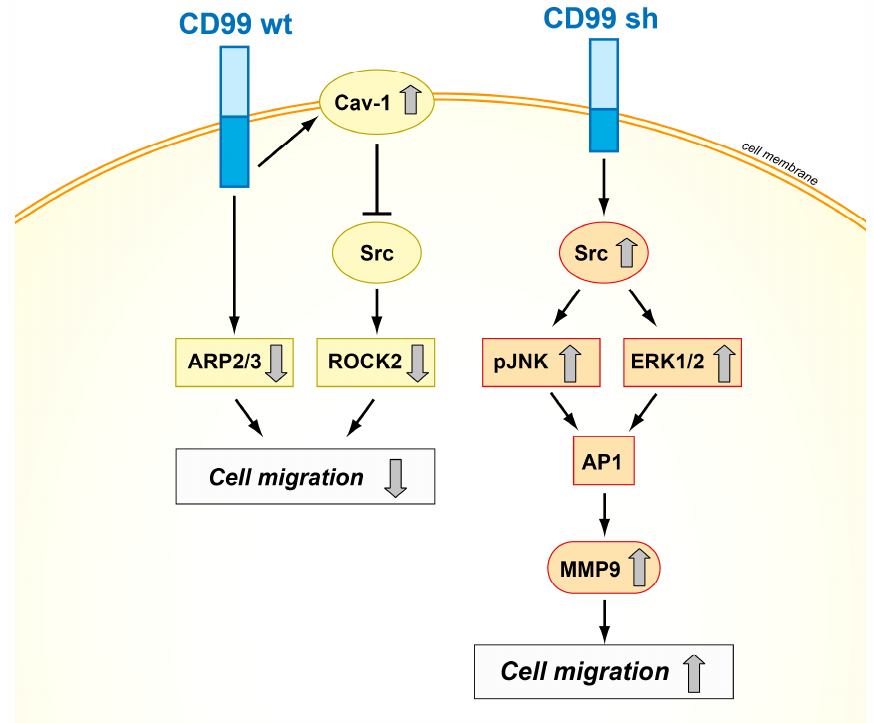
Figure 3. Schematic representation of the mechanisms of action of CD99wt and CD99sh in tumor cells. The two isoforms exhibit opposite effects on cell migration, inhibiting or activating the Src signaling pathway [18,21,53].